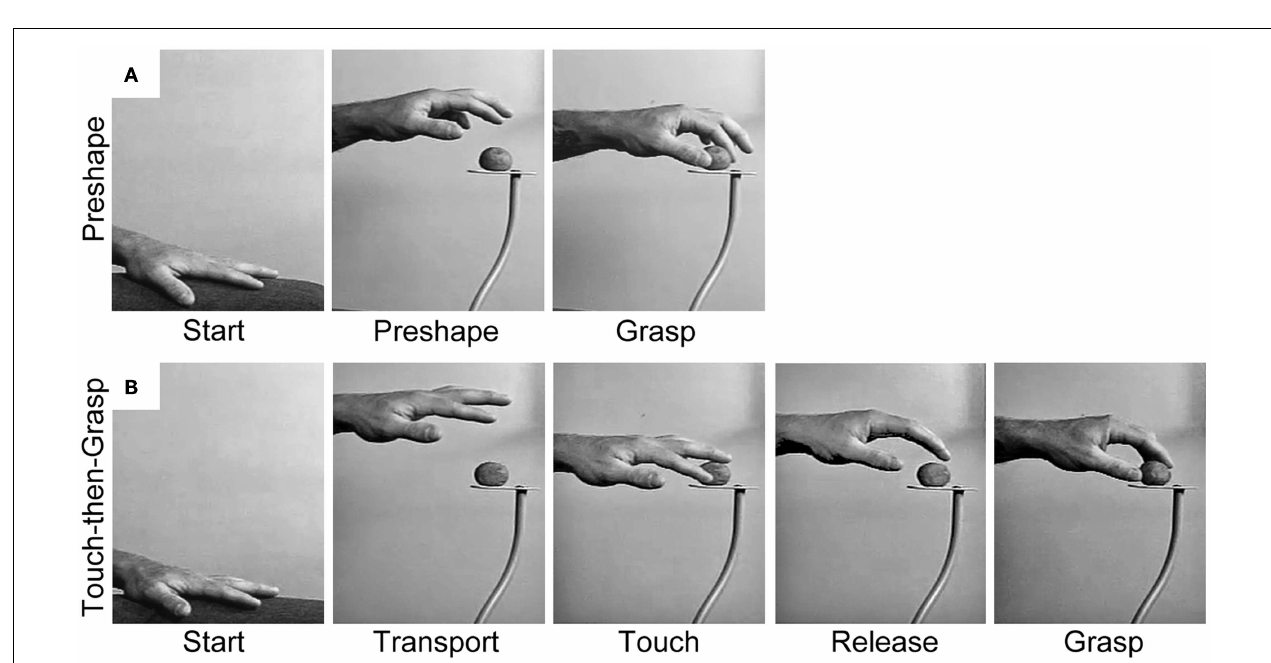
integrated such that the hand preshapes and orients to the intrinsic properties of the target before touching it. For theTouch-then-Grasp strategy the Reach and the Grasp are temporally dissociated such that the hand does not shape to the intrinsic properties of the target until after touching